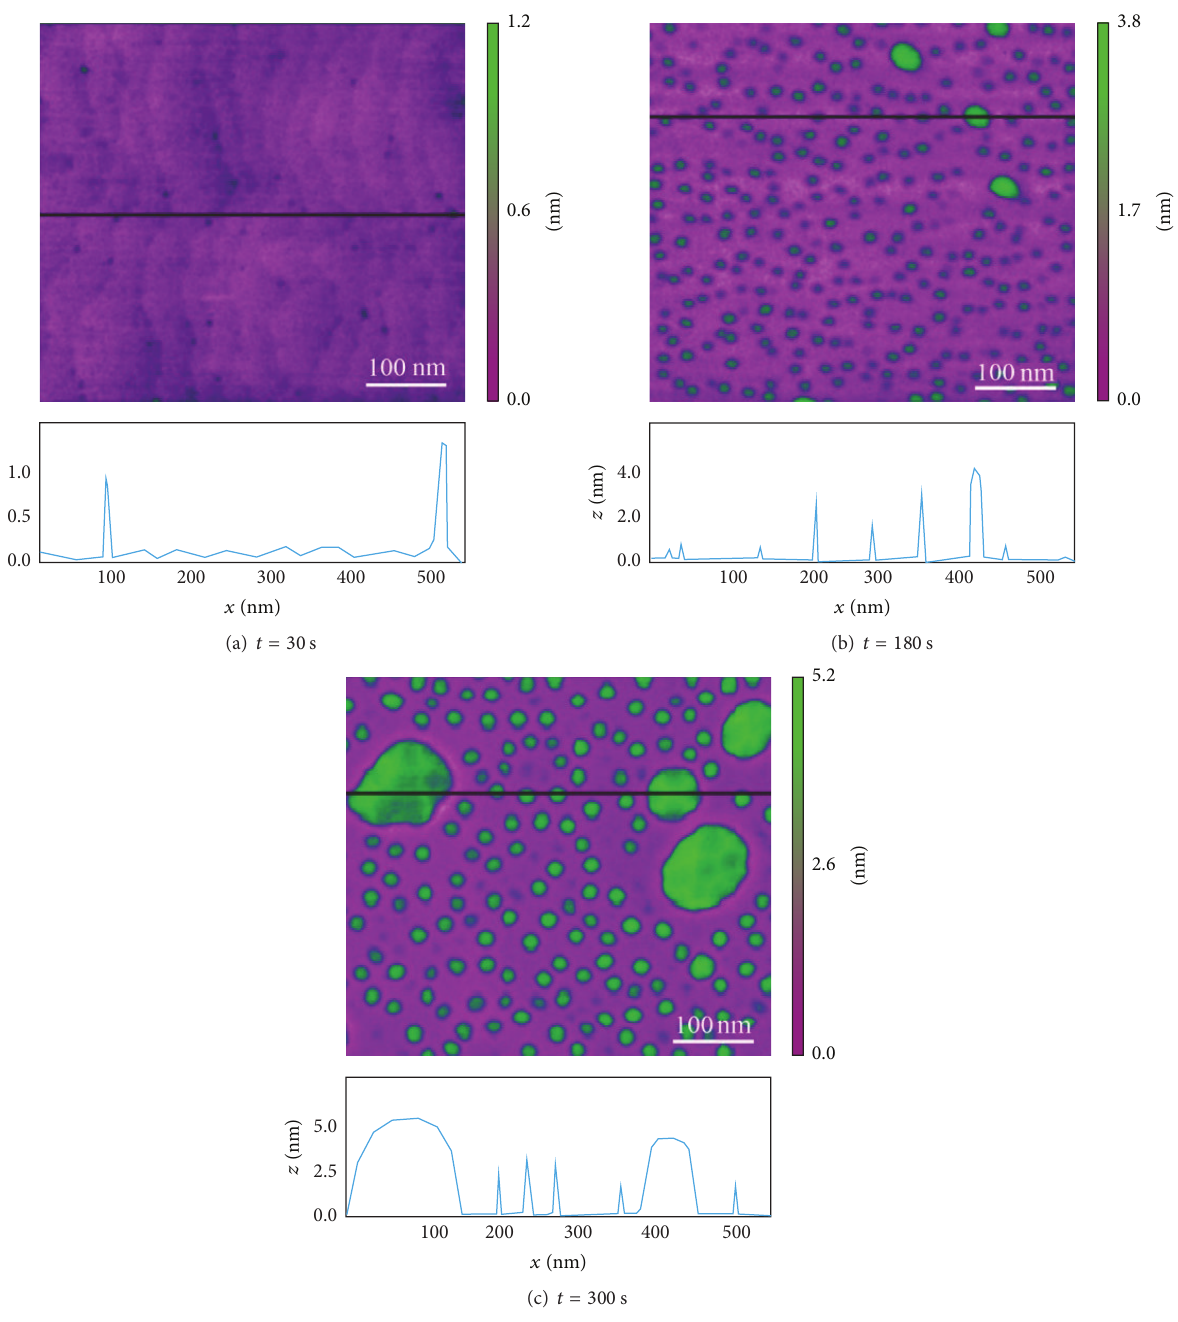
Figure 3: Morphology of InAs/GaAs at different stages of